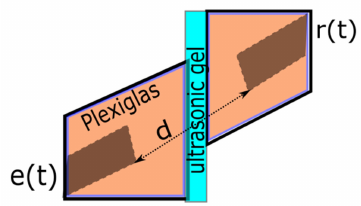
Figure 20. The positioning of the two transducers for the experimental test.